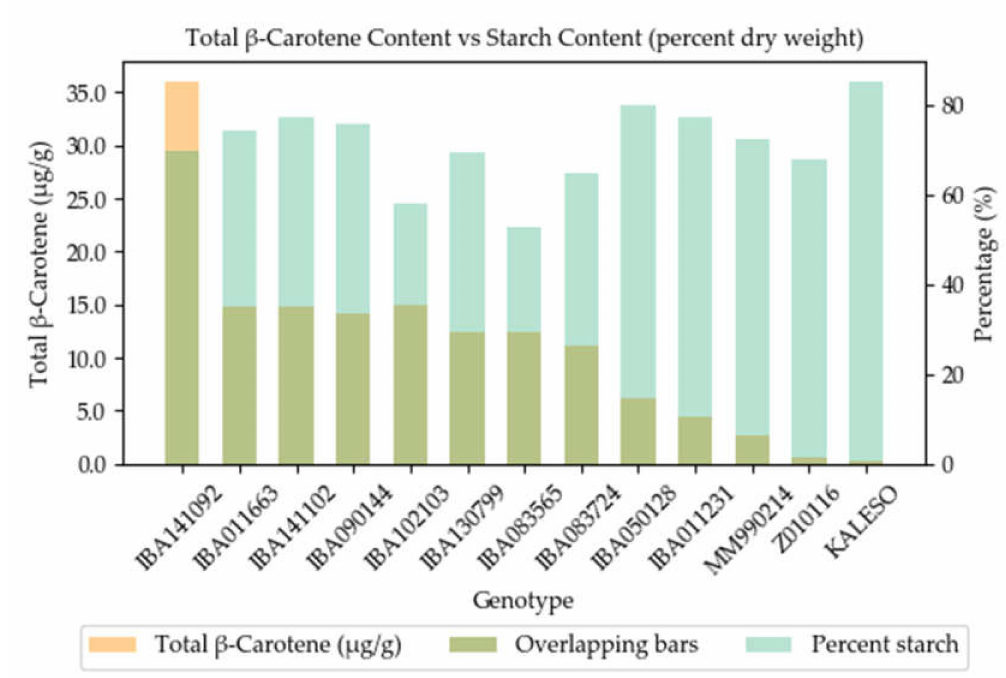
Figure 4. Comparison of total β -carotene and starch content for cassava